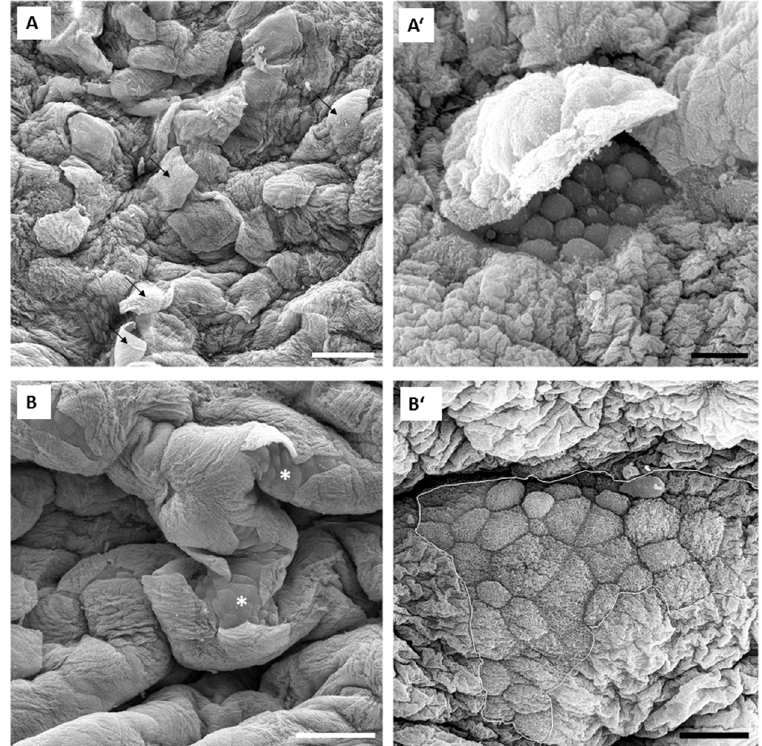
Figure 7. Representative SEM micrographs of the urothelium in in vivo experiments after 15 min exposure to 0.001% PLL with molecular weights 30–70 kDa ( A and A’ ) and 70–150 kDa ( B and B’ ). Images A’ and B’ show key features of the urothelium at higher magnifications. In image A , only individual umbrella cells desquamate (black arrows), while in image B small groups of umbrella cells desquamate or have already been peeled o ff causing occasional small desquamated areas of the urothelium (white asterisks). Images A’ and B’ show desquamated areas of the urothelium (encircled with a white line in B’ ). Exposed former intermediate cells are smaller than umbrella cells and without scalloped apical plasma membrane revealing lower di ff erentiation stage. Scale bars: 100 µ m ( A , B ), 20 µ m ( A ’, B